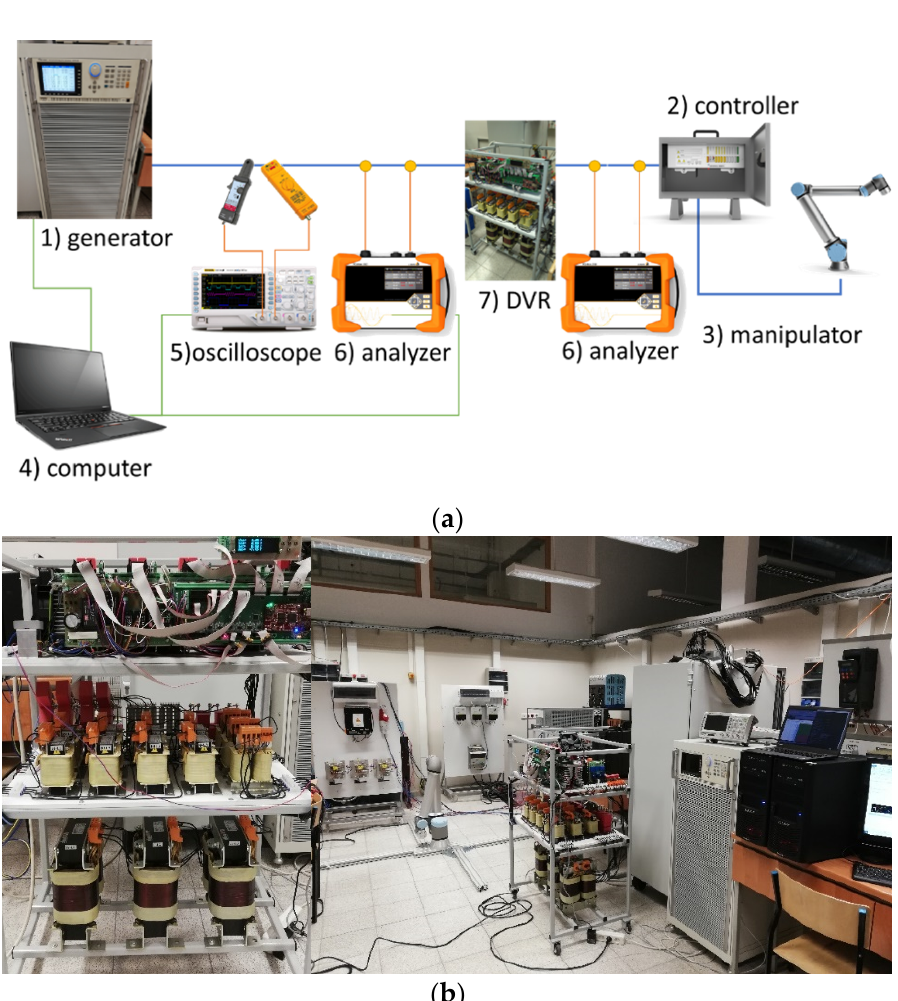
Figure 4. Schematic diagram ( a ) of the measuring system for tests with the use of a voltage conditioner and its practical implementation ( b ).